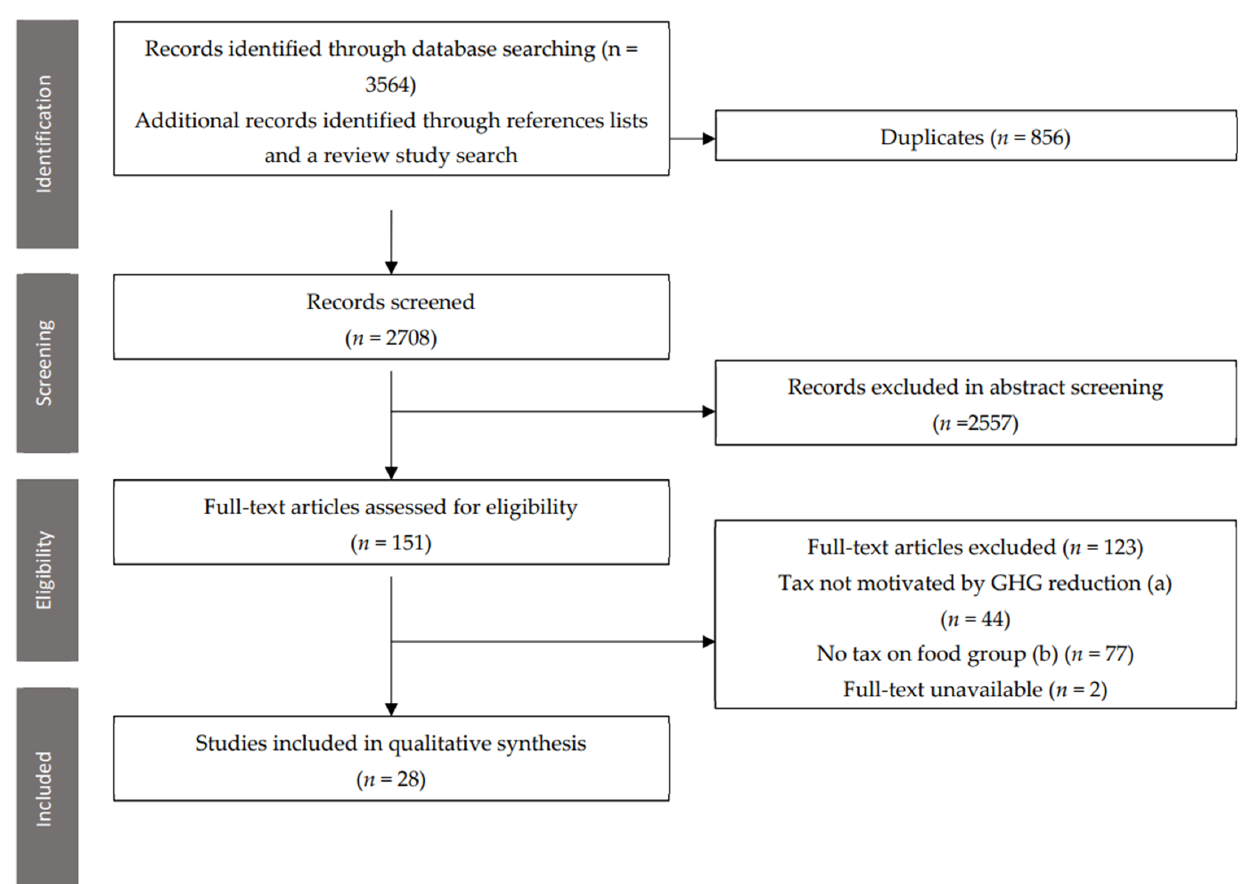
Figure 1. A PRISMA flow diagram following the process of study identification and eligibility screening.